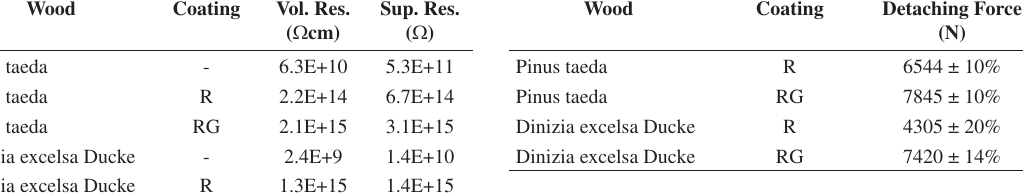
Table 5. Volumetric and superficial resistivity of uncoated and coated samples. Wood